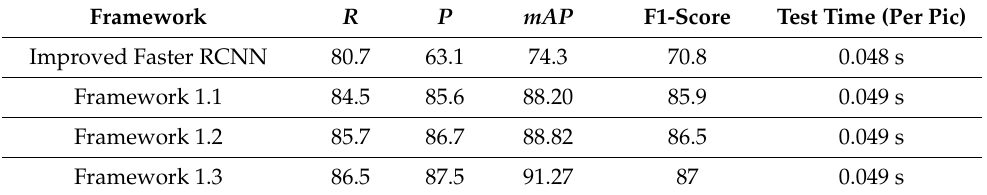
Figure 6. ( a ) P-R curve of framework1.1 ( b ) P-R curve of framework1.2 ( c ) P-R curve of framework 1.3.